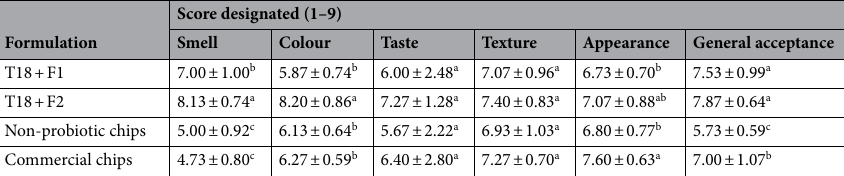
Table 6. The sensory evaluation (smell, color, taste, texture, appearance, and general acceptance) of non-probiotic potato chips, commercial potato chips, and probiotic potato chips with different prepared formulations (Tarkhineh) during 120 days storage at 4 °C. T18: Lactococcus lactis KUMS-T18 . F1: plain Tarkhineh. F2: turmeric Tarkhineh. Values shown are means ± standard deviations (n = 3). *Values are mean ± standard deviation of triplicates. a–c Means in the same row with different lowercase letters differed significantly ( p ≤